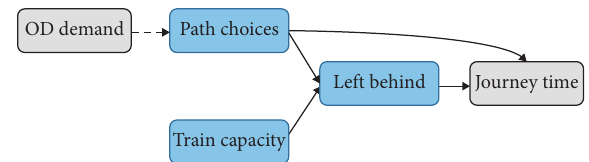
Figure 1: Relationship among critical parameters in urban rail